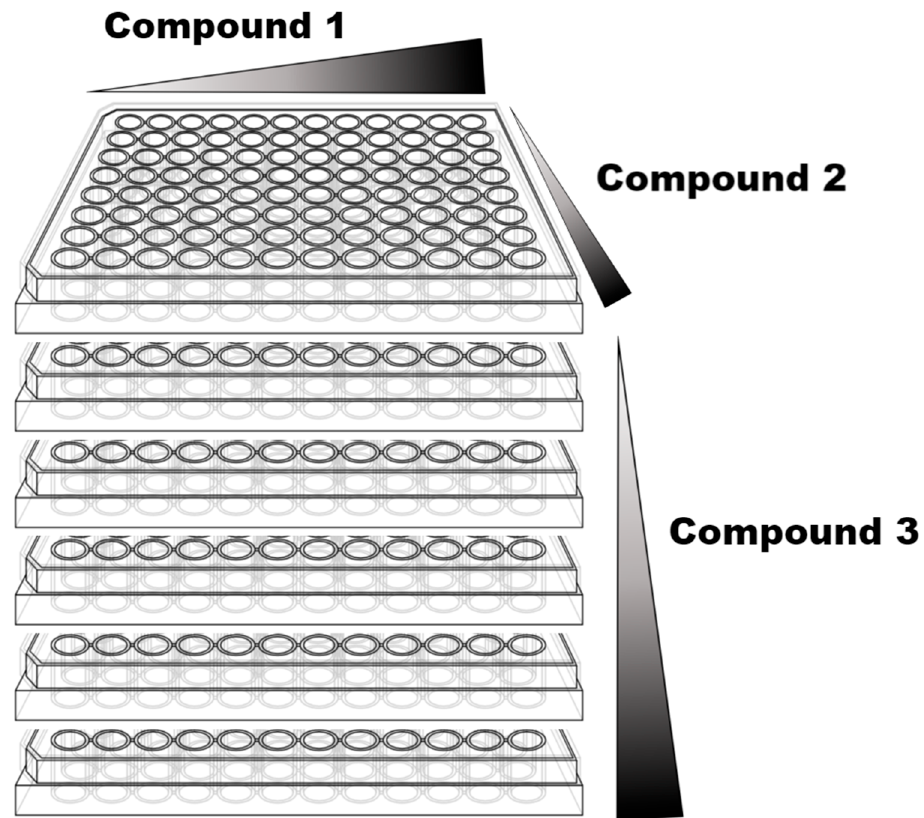
Figure 1. Checkboard plate design can be used not only for single plate experiments but also for more complex studies using three different compounds. In these cases, the concentration of each compound increases in one of the three dimensions ( x , y and z axis) as indicated in the figure.